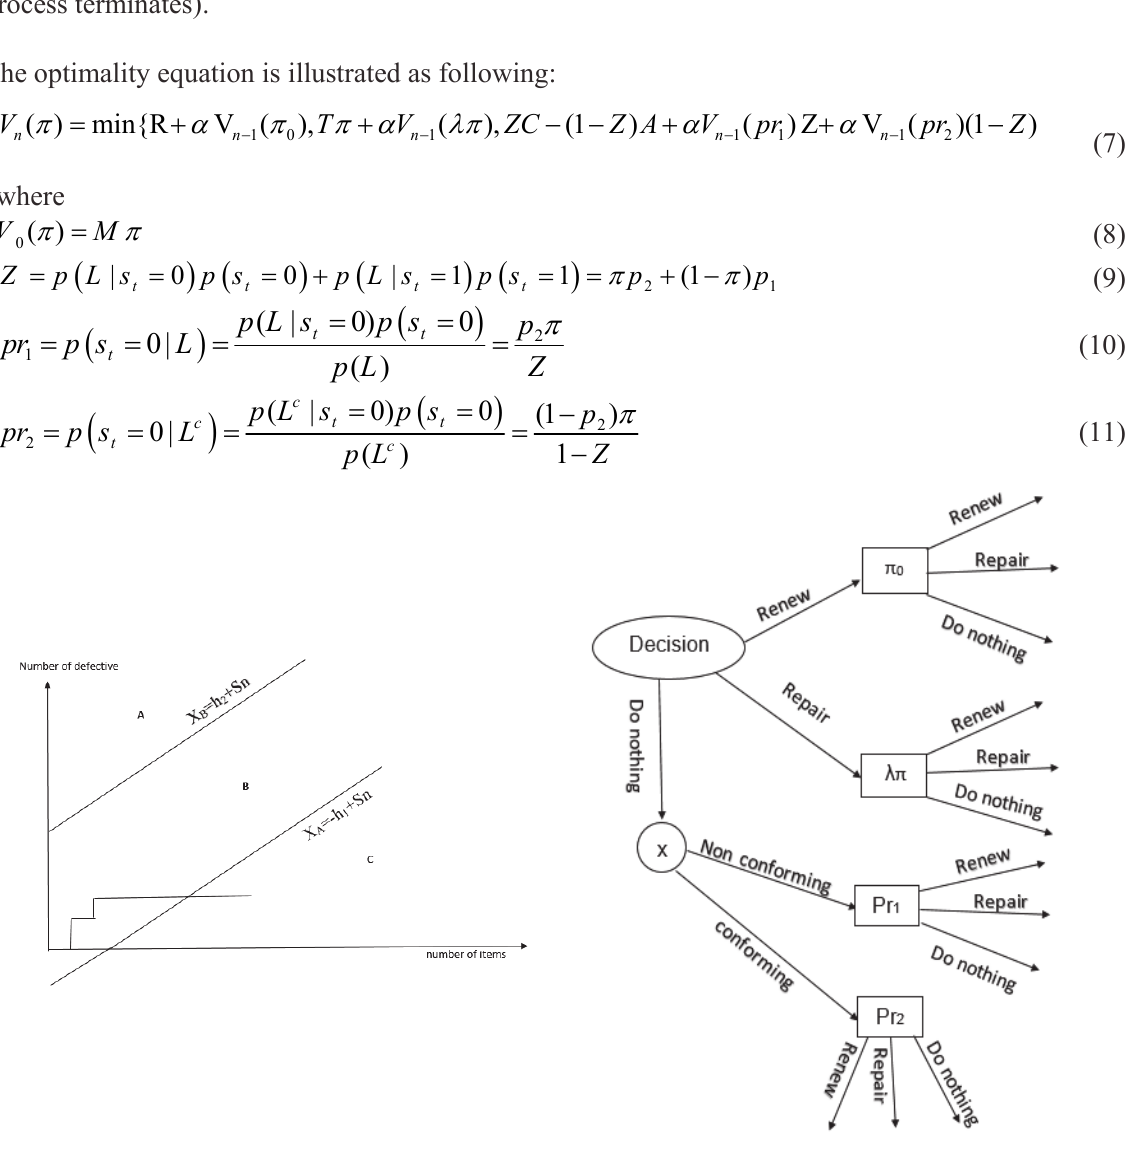
Fig. 3. Sequential sampling plan for machine replacement problem